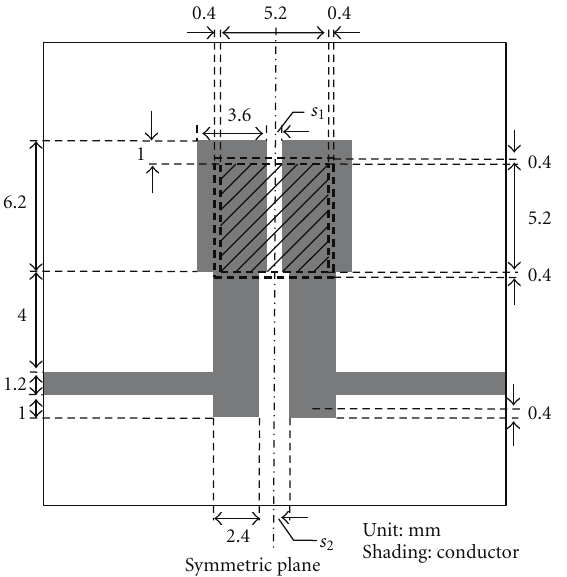
Figure 11: Metallization patterns of SIR filter.